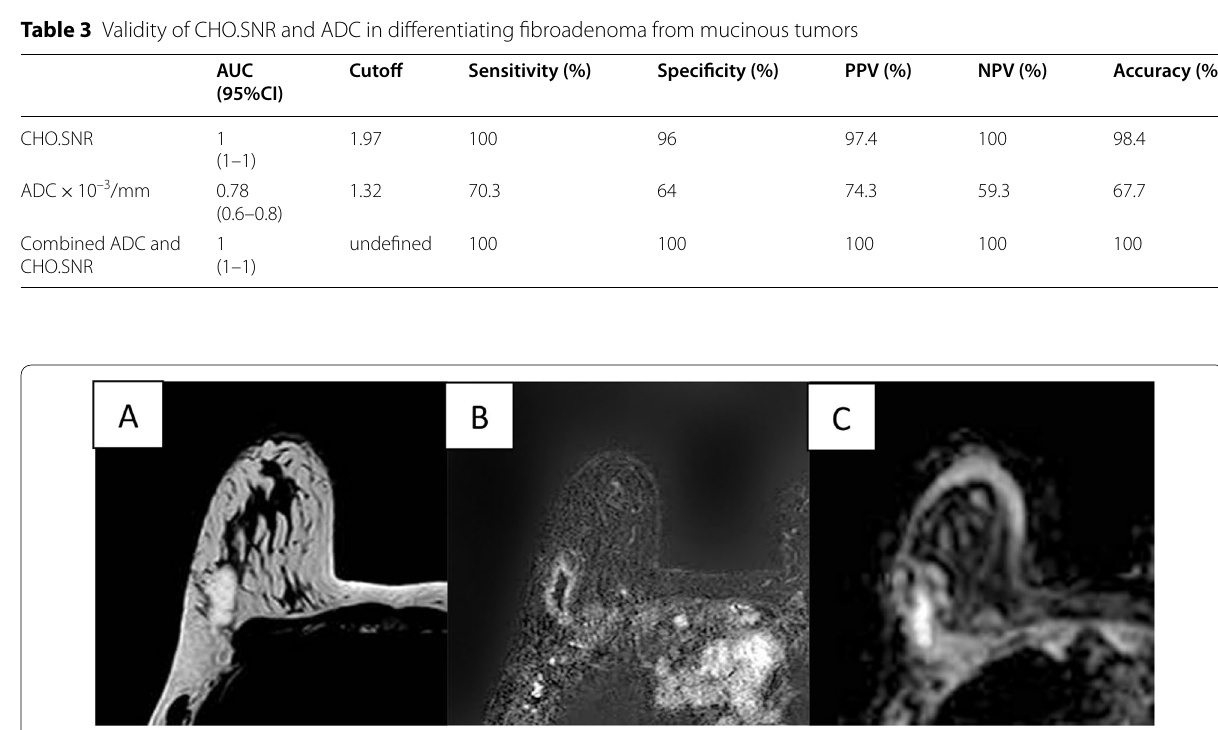
Fig. 2 A 47-year-old female with a right breast mucinous carcinoma. A Axial T2-WI image showing a non-circumscribed lesion of high signal. B Axial postcontrast T1-WI with subtraction showing irregular marginal contrast enhancement. C Axial ADC map, the ADC value of the lesion was 1.43 10 − 3 mm 2 ×